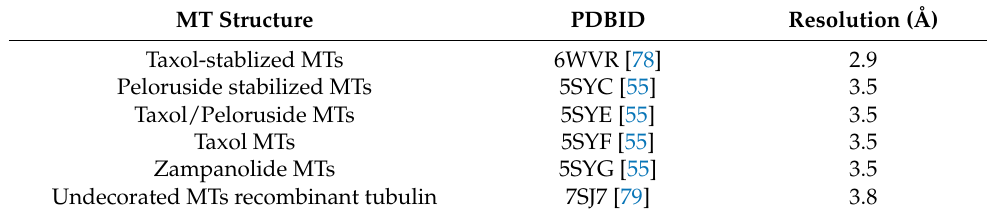
Table 2. High-resolution CryoEM MT